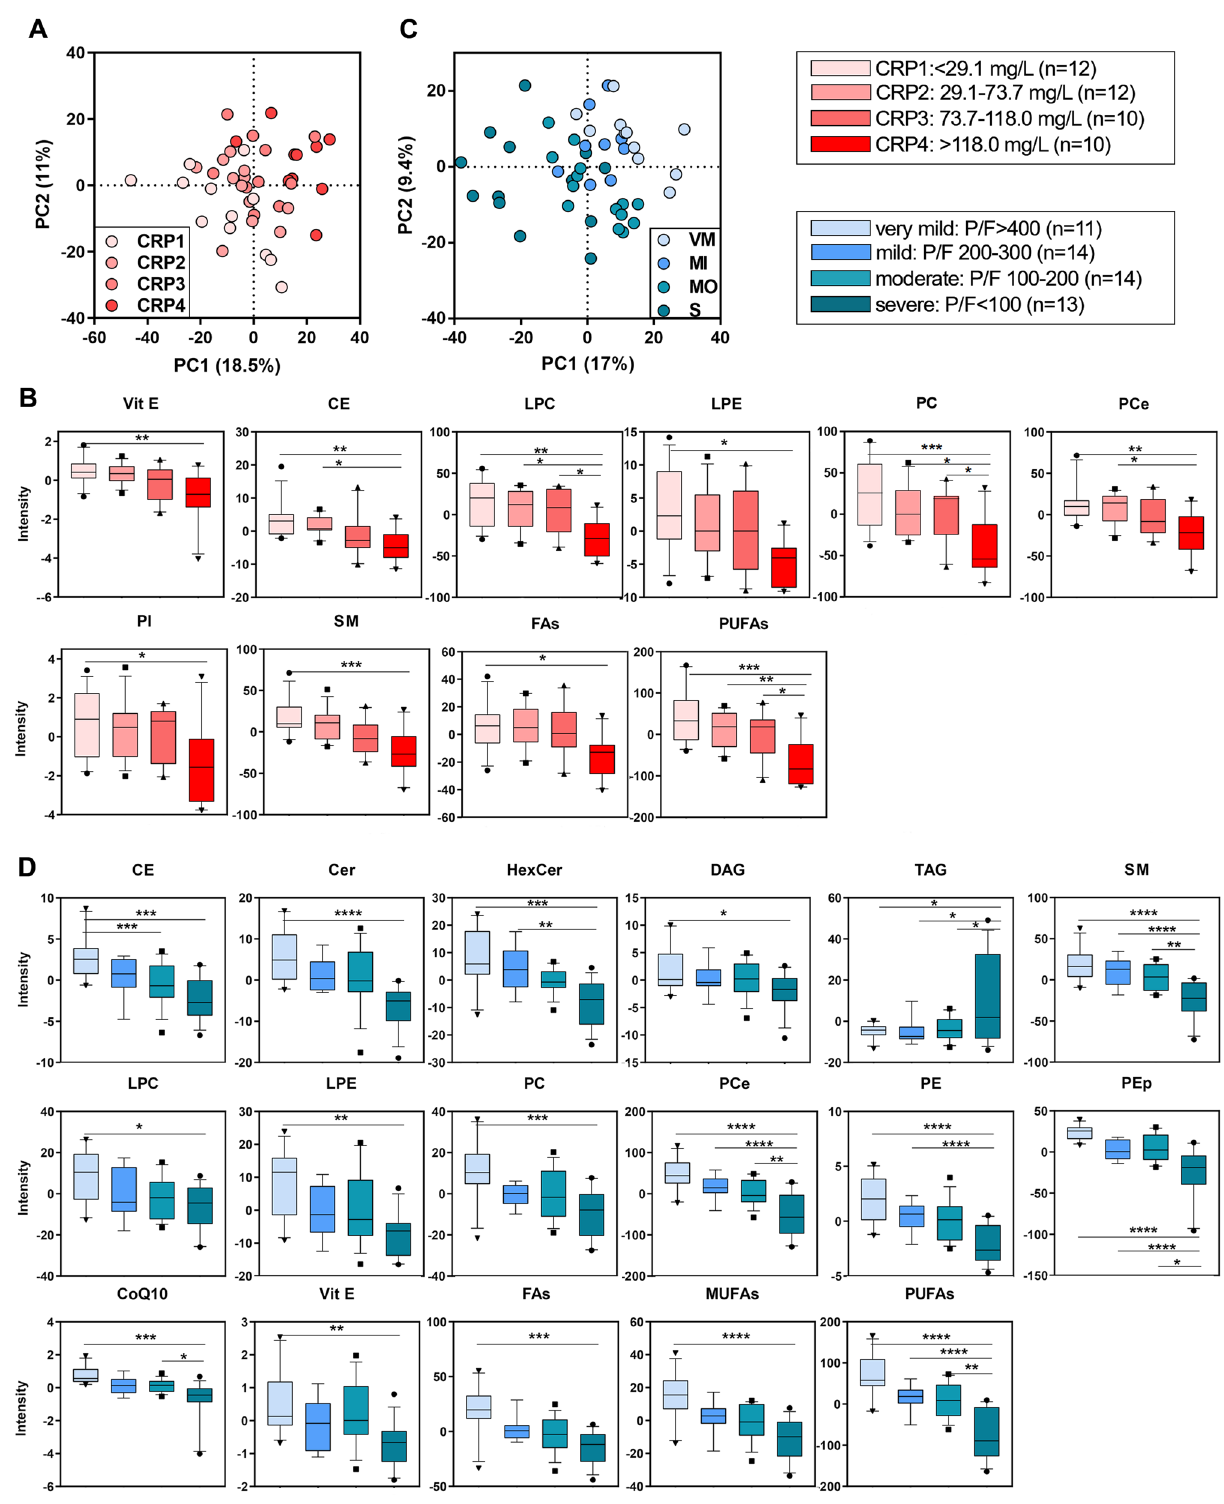
Figure 1. Discriminant analysis (score plot) of the lipidome as a function of inflammation ( A ) and hypoxia ( C ). Lipid classes with a statistical significance are shown in boxplots in function of increasing inflammation ( B ) and hypoxia ( D ). Boxes: 25th–75th percentiles; lines: 10th–90th percentiles; crossing lines: median values; separate points: outliers. Statistical tests were performed by one-way ANOVA and the Bonferroni post hoc